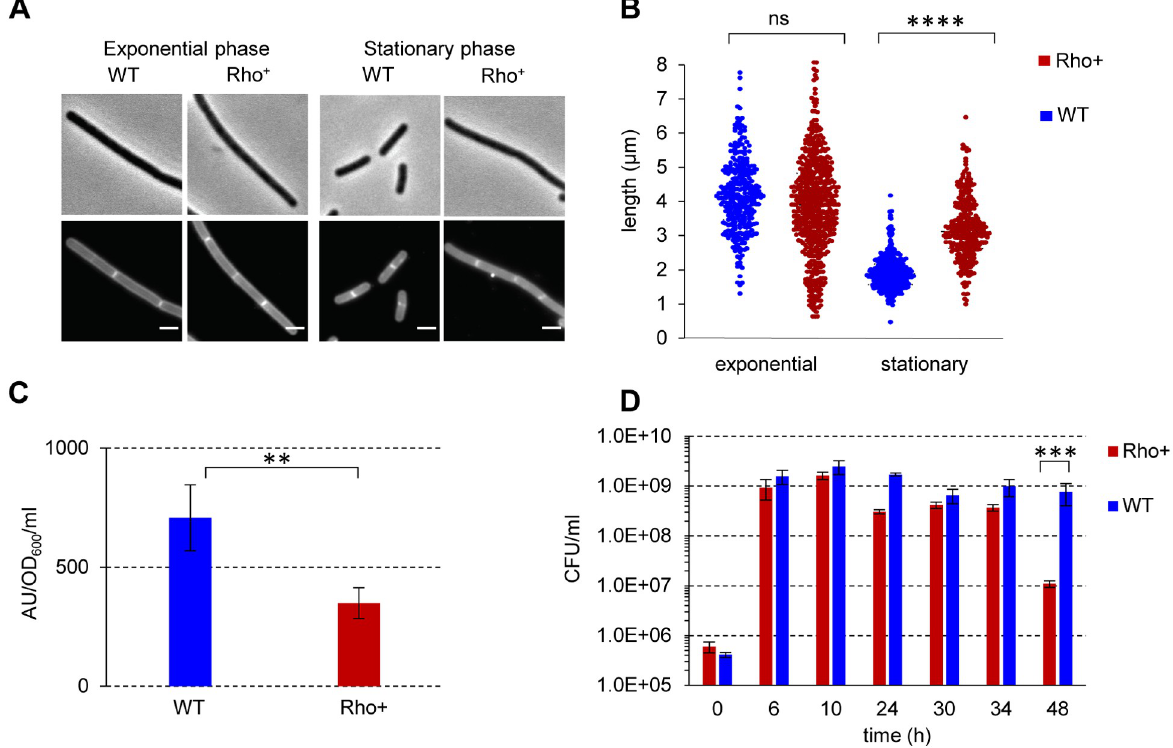
Fig 7. Morphology and long-term survival of B . subtilis Rho + cells. Microscopy images ( A ) and cell length measurement ( B ) of B . subtilis WT and Rho + under conditions of exponential growth and stationary phase. (A) Phase contrast (upper panel) and fluorescence (lower panel) images of WT and Rho + cells stained with Nile Red at OD 600 0.2 and 1.8. Scale bars correspond to 2 μ m. (B) The post-acquisition treatment of the images and determination of the mean cell lengths was as described in Materials and Methods. Statistical significance was estimated with a nested t-test, performed with Prism 9 (GraphPad Software, LLC). Note that the plot show the pooled values of the replicates. The displayed p-values are as follows: ���� , p < 0.0001; ns (non-significant), p > 0.05 using a nested t-test. ( C ) Level of ppGpp under stationary phase. B . subtilis BSB1 WT and Rho + cells were grown in defined SM medium supplemented with 0.5% (w/v) of casamino acids to stationary phase (OD 600 1.5). The ppGpp levels were assessed as described in Materials and Methods. Plotted are the mean values and SD from three independent experiments. The displayed p- value: �� , p � 0.01, using a two-tailed t-test. ( D ) Effect of Rho on long-term survival of B . subtilis . B . subtilis WT and Rho + cells were grown in LB medium at 37˚C with vigorous shaking during 48 hours. At the specified growth time, cells were plated on LB plates, and cell survival in cultures was assessed by the number of viable cells forming colonies (CFU) after 18 hours of incubation at 37˚C. Plotted are the average values from three independent experiments each incorporating three biological replicas of each strain. The displayed p-value: ��� , p � 0.001 using a two-tailed t-test.